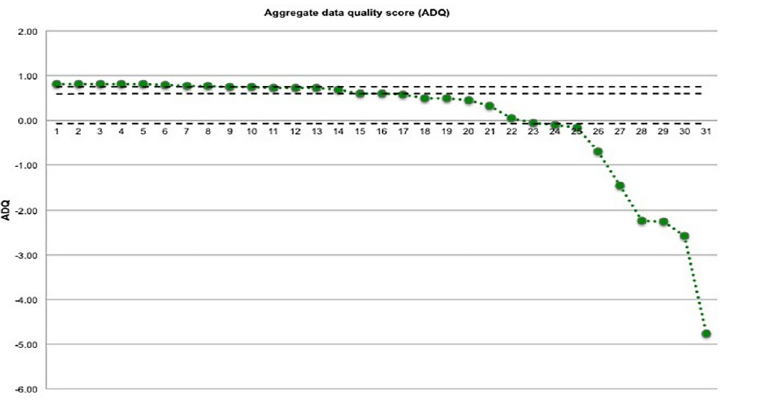
Fig 1. ADQ score for the variables analyzed in the indirect audit. REPLICCAR II,